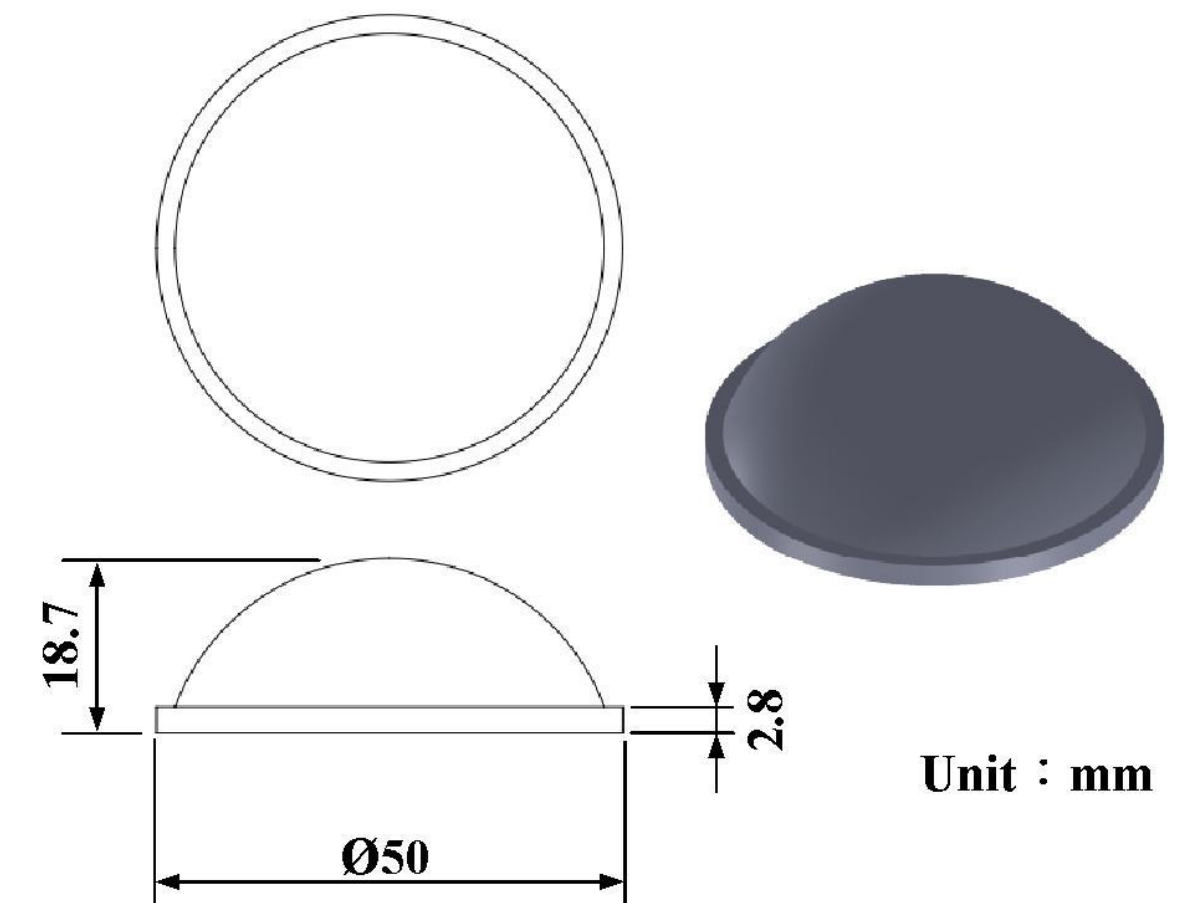
Figure 1. Flow diagram of the experimental methodology.